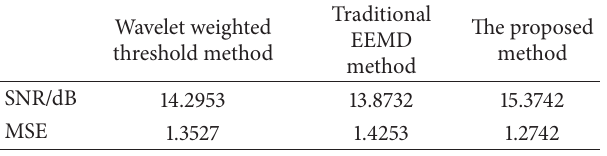
Figure 5: Feature values of IMF1 based on SVD.